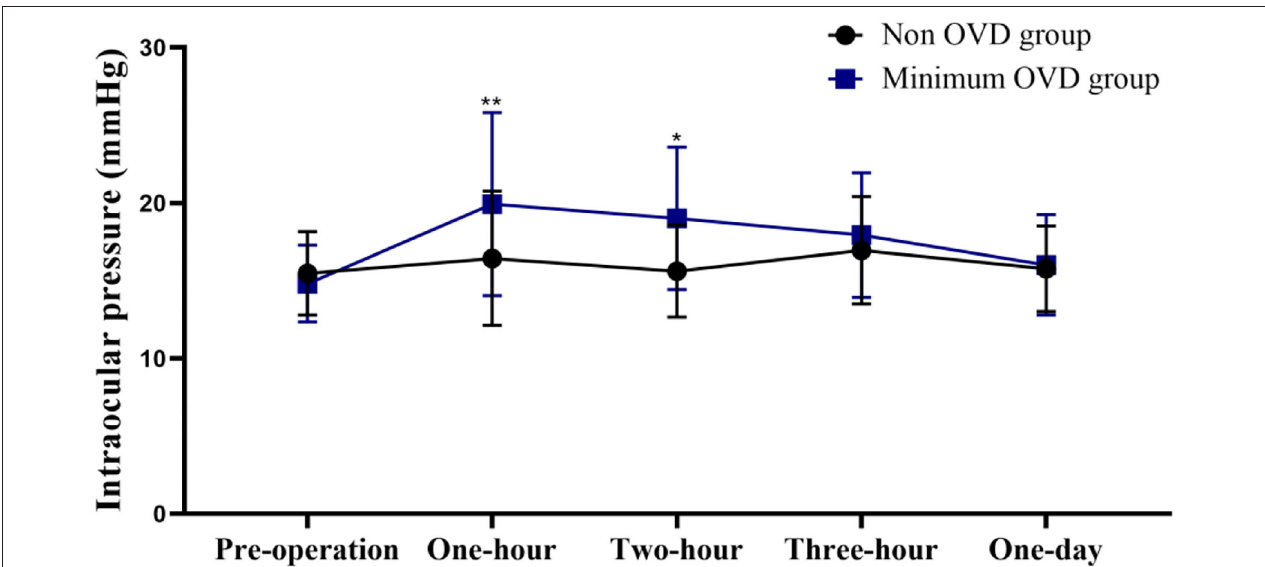
FIGURE 2 | Intraocular pressure (IOP) of the non-OVD group and min-OVD group at each follow-up time point. Error bars represent standard deviation, * P < 0.05; ** P < 0.01.